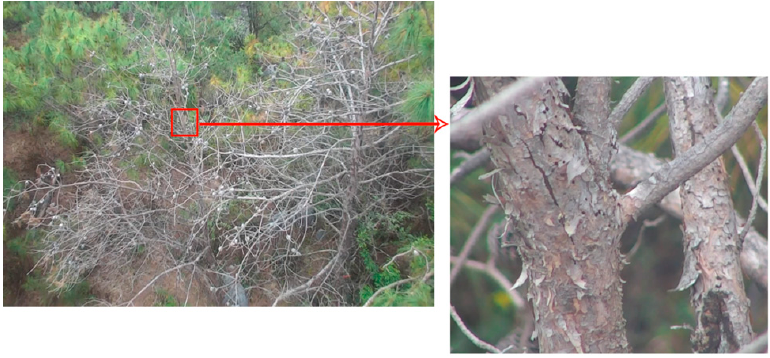
Figure 5. The entrance and exit holes of Pine shoot beetles (PSBs) captured by the M200+Z30.